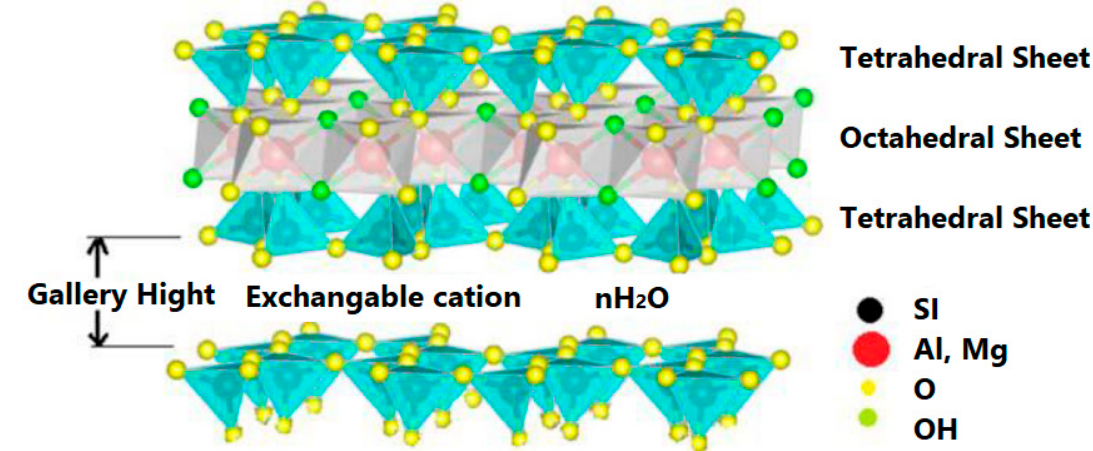
Figure 2. Classification of clays.